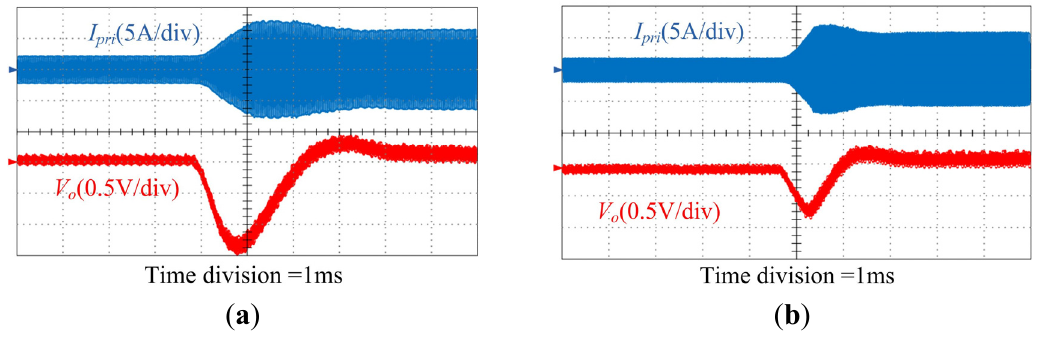
Figure 27. Dynamic responses of the converter for load step transient (4 A–20 A). ( a ) Using conventional PI controller; ( b ) Using adaptive PI controller.